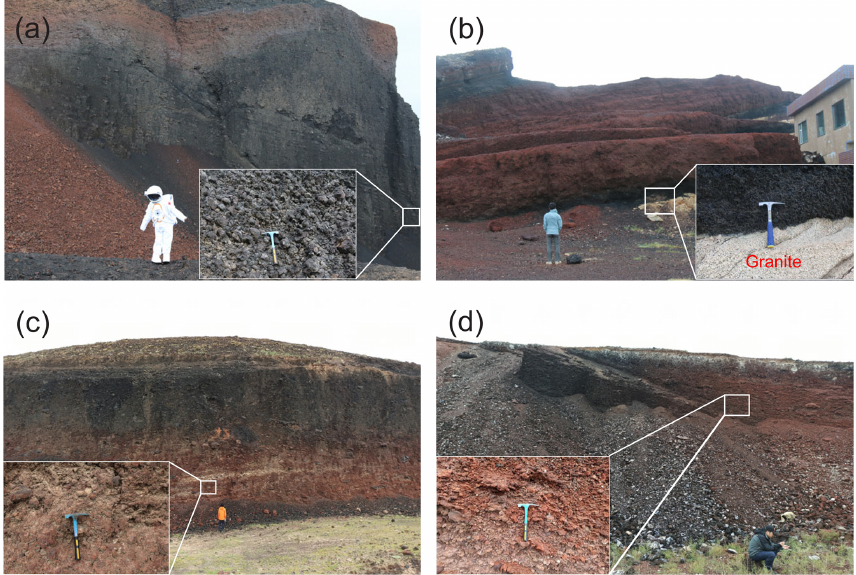
Figure 2. Field photographs of the Wulanhada Volcanic Field. (a) Nanliandanlu volcano and detail of scoria cone. (b) Heinaobao volcano and the scoria material overlays the granite. (c) Hongshan volcano and detail of scoria cone. (d) Huoshaoshan volcano and detail of scoria